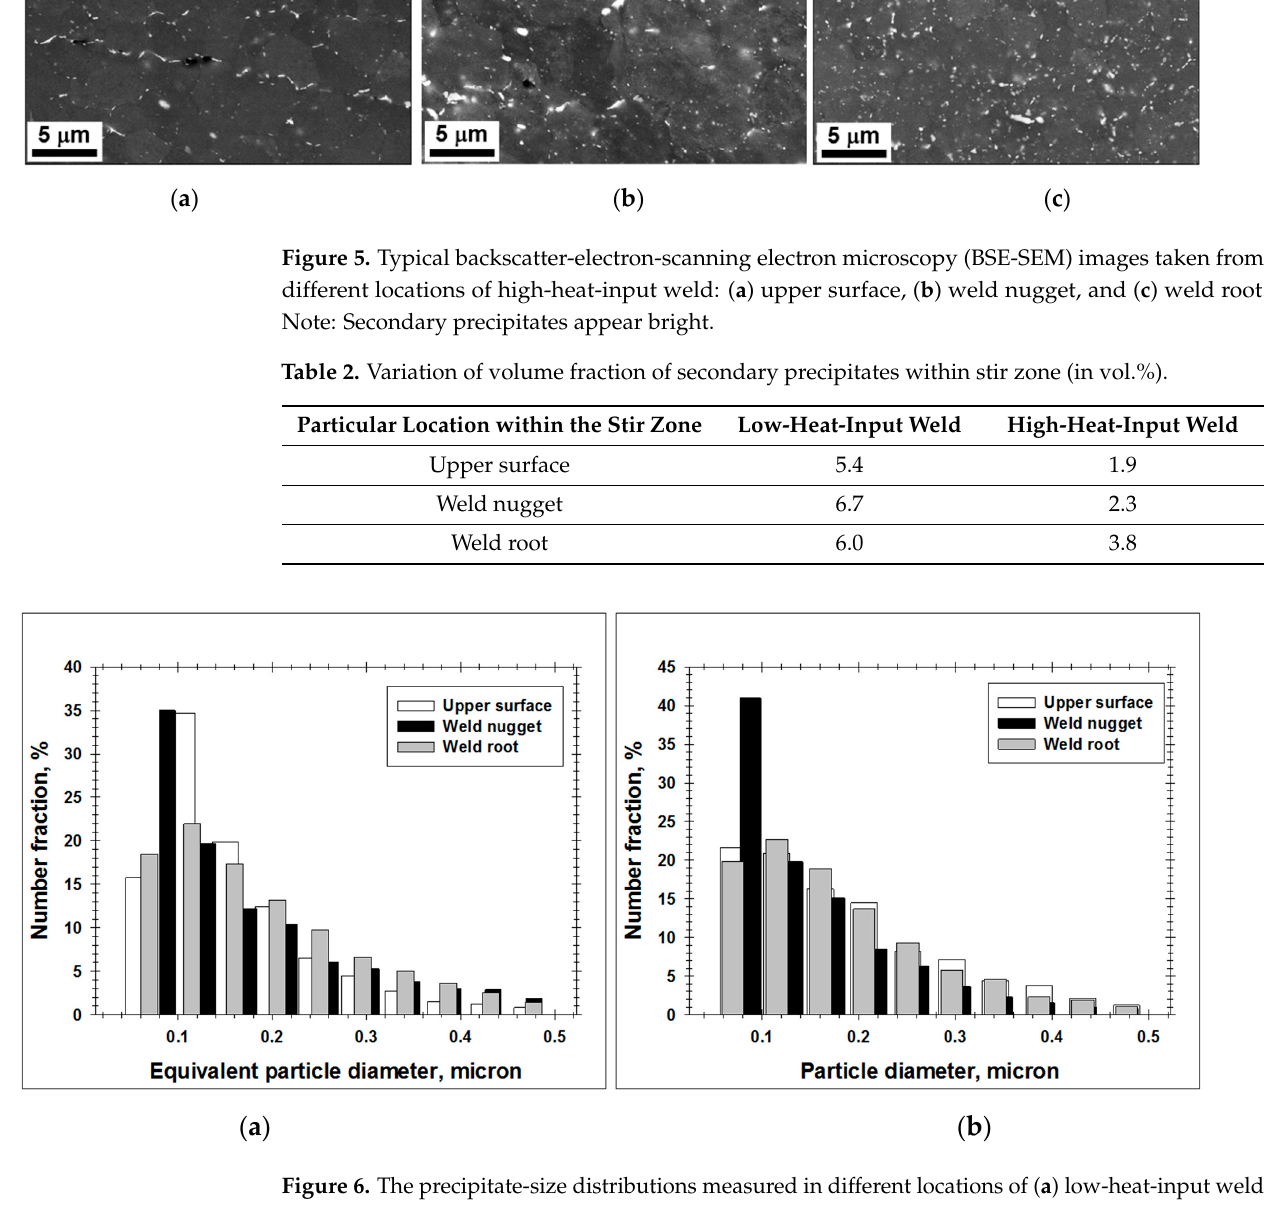
Figure 4. Typical backscatter-electron-scanning electron microscopy (BSE-SEM) images taken from different locations of low-heat-input weld: ( a ) upper surface, ( b ) weld nugget, and ( c ) weld root. Note: Secondary precipitates appear bright.